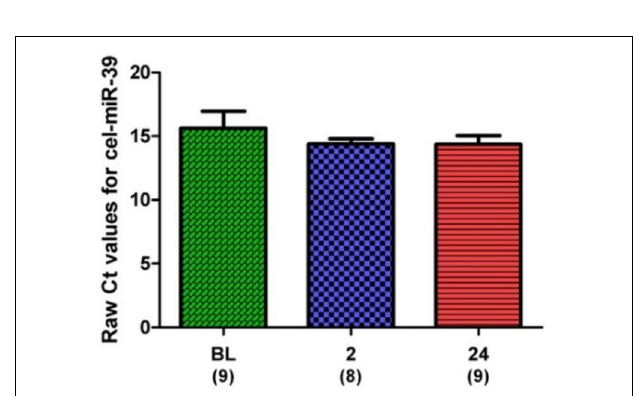
visualization of ± 50 nm exosome-sized particles was also achieved ( Figure 2B